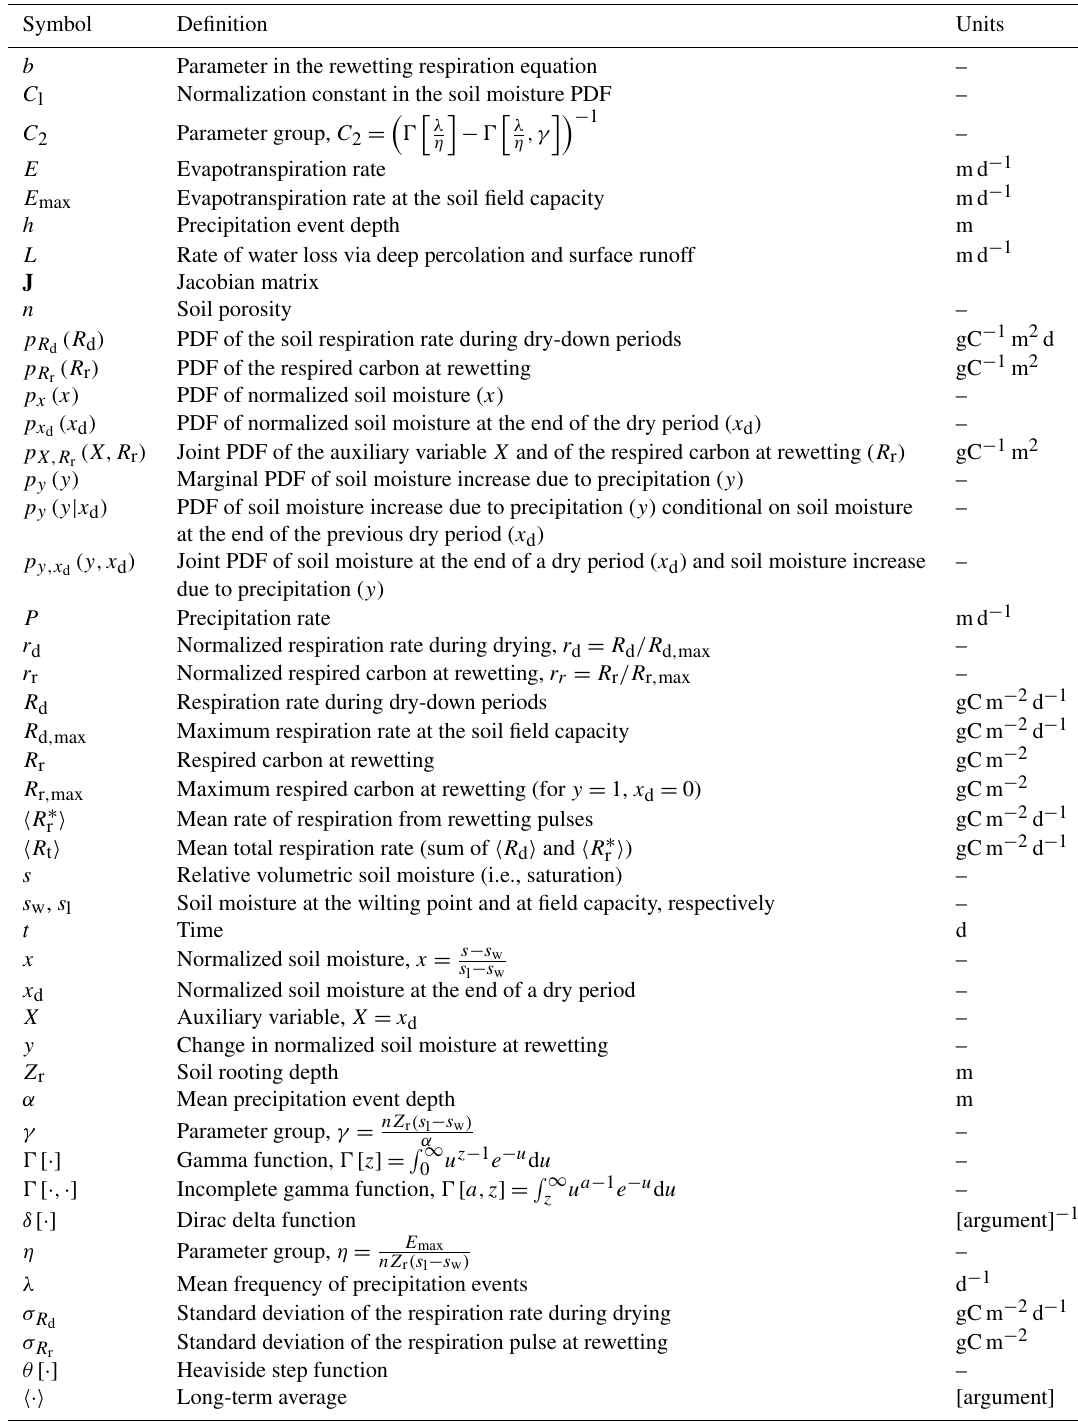
Table 1. Symbol definitions and units. Symbol p z represents the probability density function (PDF) of the stochastic variable z indicated in the